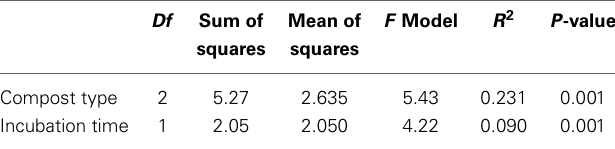
Table 1 | PERMANOVA results of 454 data